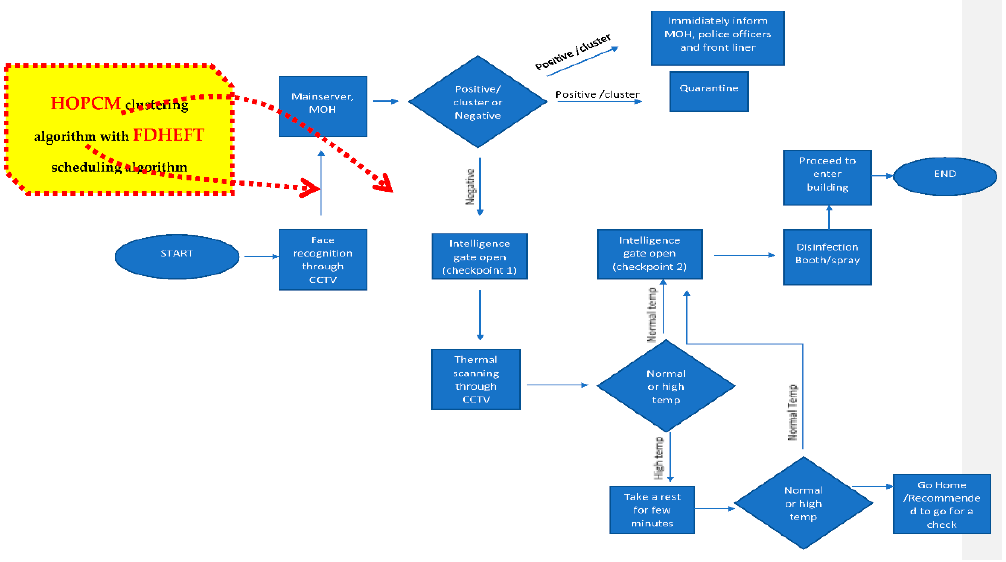
Figure 9. Processes flow of cloud-based smart health.